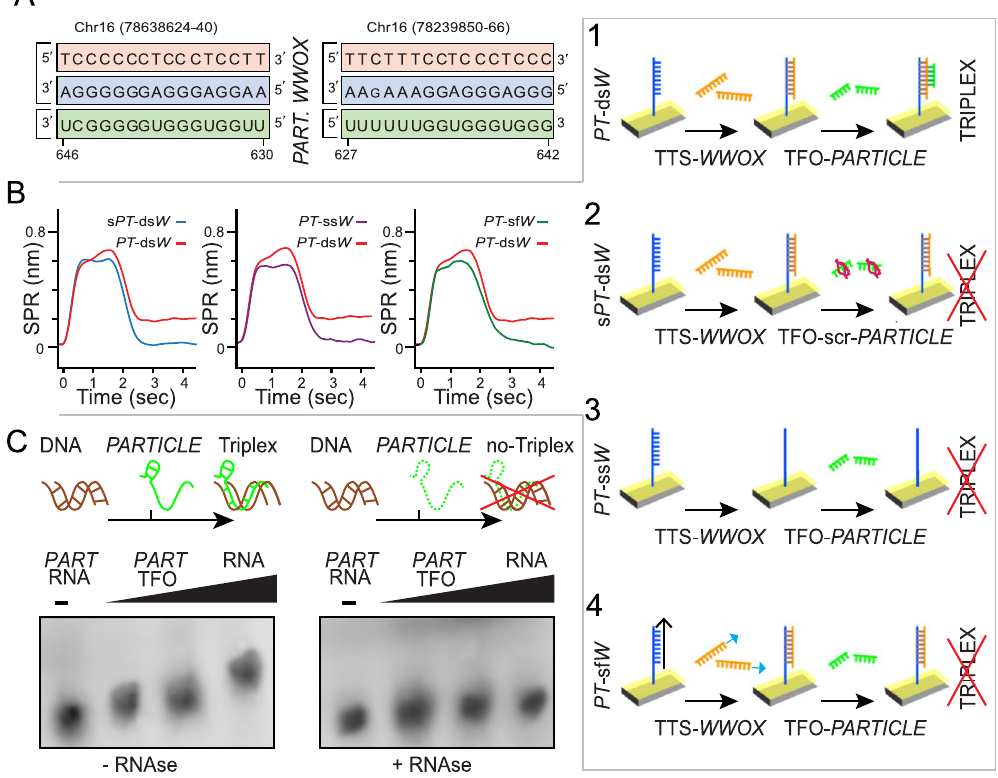
Figure 2. PARTICLE forms a triplex with WWOX . ( A ) Triplex-forming oligonucleotide motifs within PARTICLE (green) identified using Triplexator software to target triplex sites in WWOX (blue and red) to form a triple helix. Subscript base indicates a mismatch in the sequence. ( B ) Representative surface plasmon resonance (SPR) sensorgrams illustrating spectral shift following PARTICLE triplex formation with the duplex WWOX region ( PT -ds W , red line, schematic B1) in comparison to controls (scrambled PARTICLE on duplex WWOX region; s PT -ds W , blue line, left, schematic B2); PARTICLE on single stranded WWOX target ( PT -ss W , purple, middle, schematic B3); PARTICLE on duplex shuffled WWOX region ( PT -sf W , green, right, schematic B4)), n > 3. ( C ) Electrophoretic mobility shift assays (EMSA) with gels (cropped) showing triplex formation (T) with incremental concentrations (0, 0.2, 2, 20 nM horizontal black triangle) of TFO: PARTICLE 627-646 RNA with duplex WWOX target region and absence with single WWOX (TTS_hit_1) oligo or following treatment with RNase